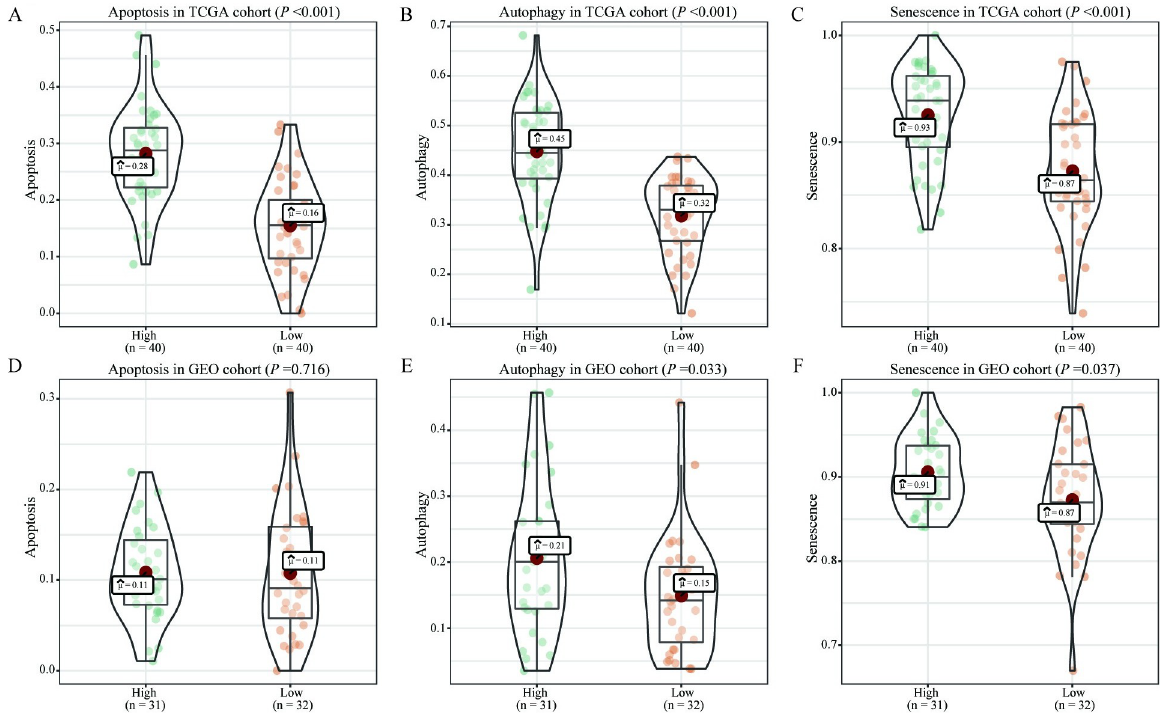
Fig 3. Association between CARD11 expression and different biologically related pathways. ( A-C ) Correlation analysis showed that in TCGA database, patients with high CARD11 expression had higher scores of apoptosis, autophagy, and cell senescence related pathways. ( D-F ) In GEO database, patients with high CARD11 expression had higher autophagy and senescence related pathway scores, while there was no significant difference between the two groups in apoptosis related pathway